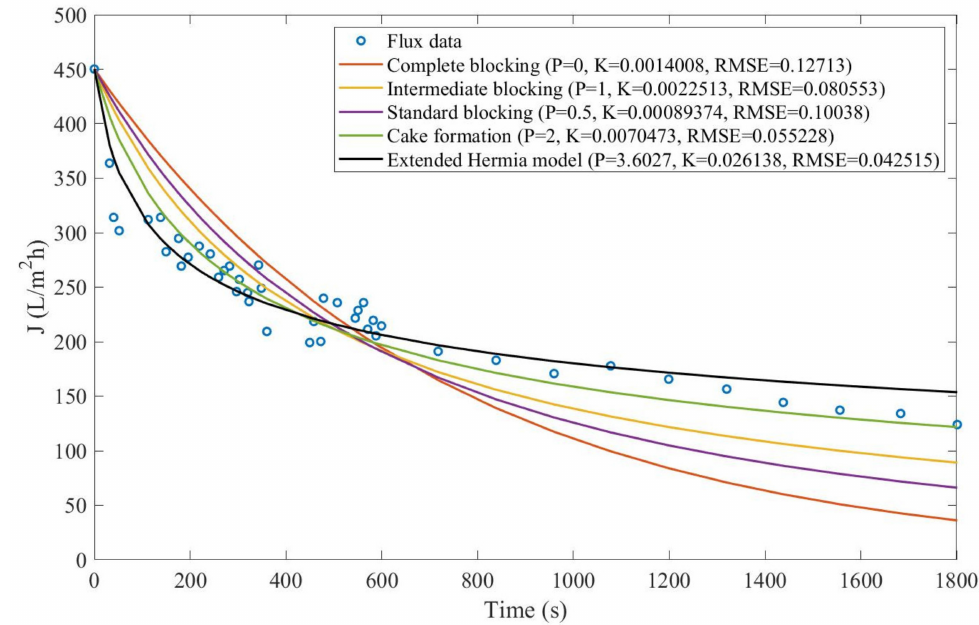
Figure A36. Model fitting for dead-end ultrafiltration of nanoparticles (97 mgNPs/L) from polishing wastewater at 0.4 bar considering the four original pore-blocking mechanisms and the extended Hermia model (22).